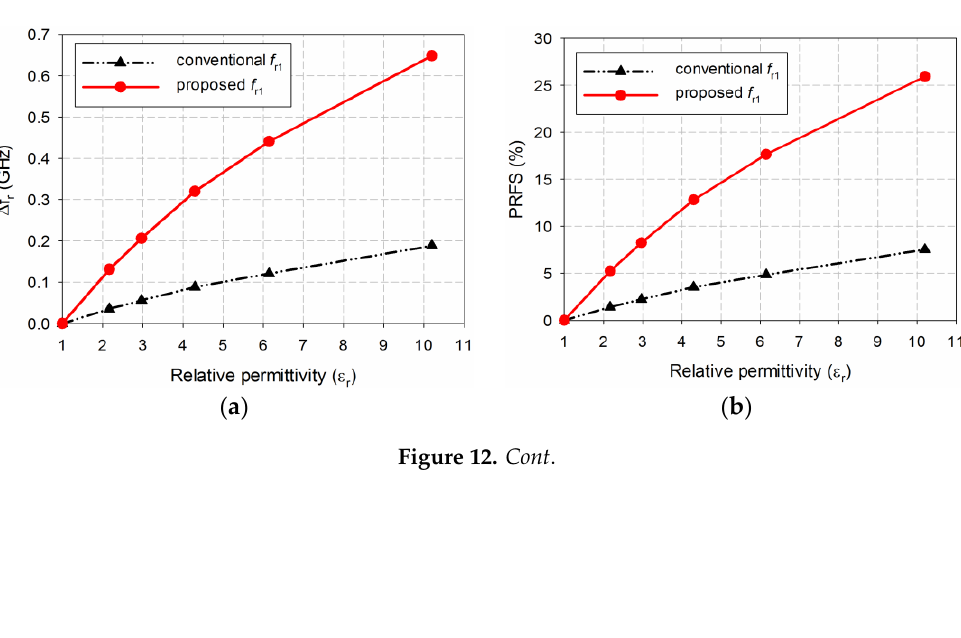
Figure 11. Simulated S 11 characteristics of the conventional and proposed patch antennas for MUTs in Table 2: ( a ) Conventional; ( b ) proposed.